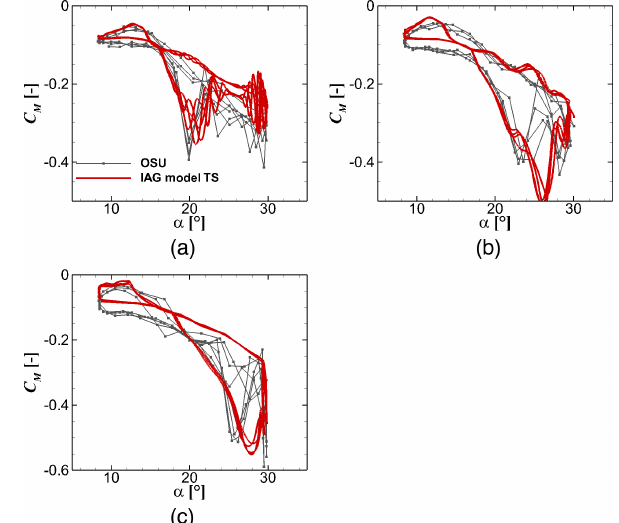
Figure 17. Pitching moment reconstruction by the IAG model in comparison with the measurement data (Ramsay et al., 1996) for (cid:49)t = T/ 1440 using the actual angle of attack in the experimental campaign at various k values. From (a) to (c) : k = 0 . 036, k = 0 . 073 and k = 0 . 111. S801 airfoil, α = 20 and (cid:49)α = 10 ◦